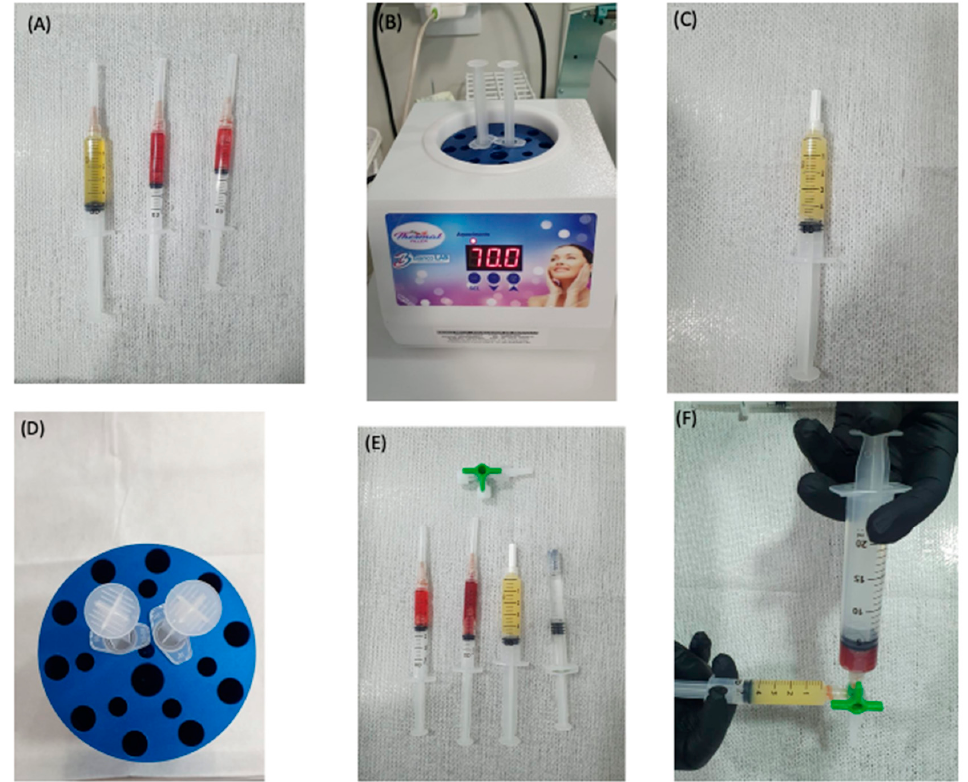
Figure 3. Obtaining the PRP–HA cellular gel matrix. ( A ) Syringes containing the plasma and buffy coat; ( B ) Plasma being heated up to 70 ◦ C for 15 min; ( C ) The plasma gel; ( D ) The cooling device; ( E ) The buffy coat, plasma gel, hyaluronic acid, and three-way connector before mixing; ( F ) Mixing of the buffy coat with the plasma gel.